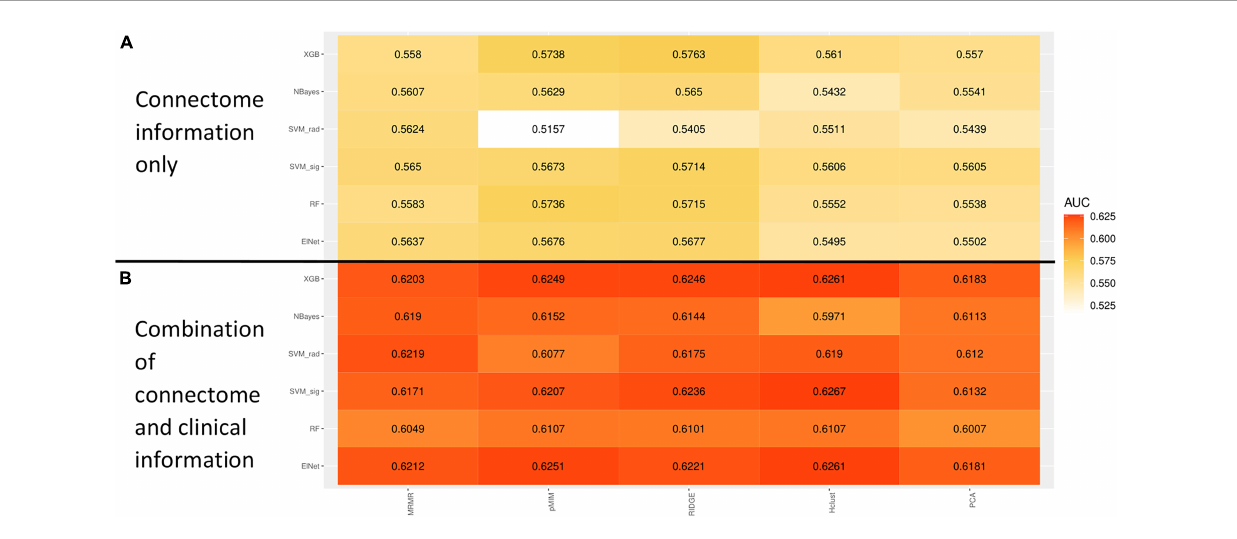
FIGURE5 Heatmap showing the mean receiver operating characteristics (ROC) area under curve (AUC) across 100 validation folds from combination of different machine-learning classifiers and feature selection methods using imaging variables alone (A) or combination of clinical and imaging variables (B)